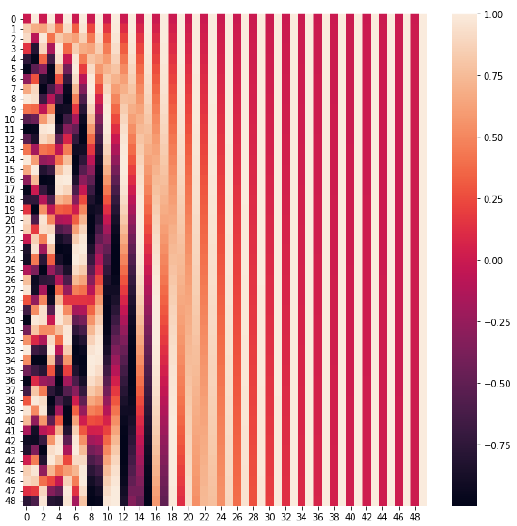
Figure 9. Position-embedding matrix.